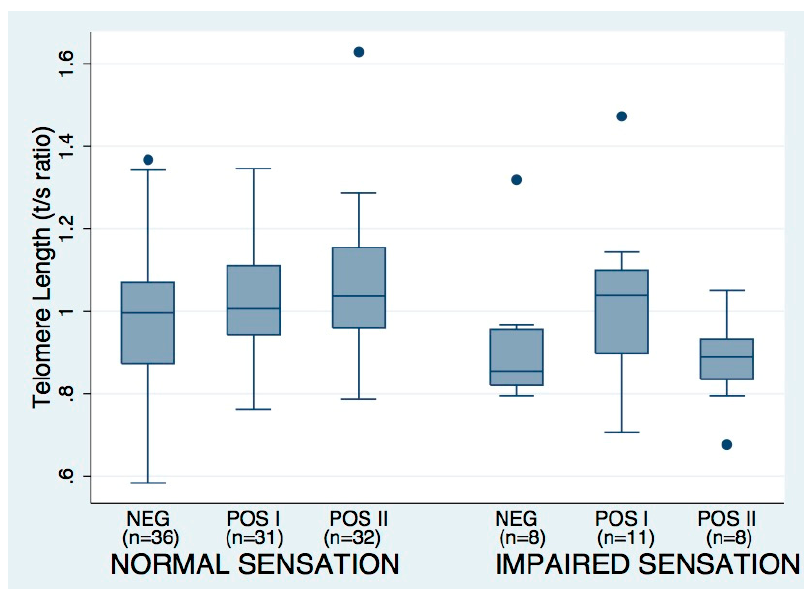
Figure 2. Telomere length by HTLV status and presence or absence of vibration sense impairment.